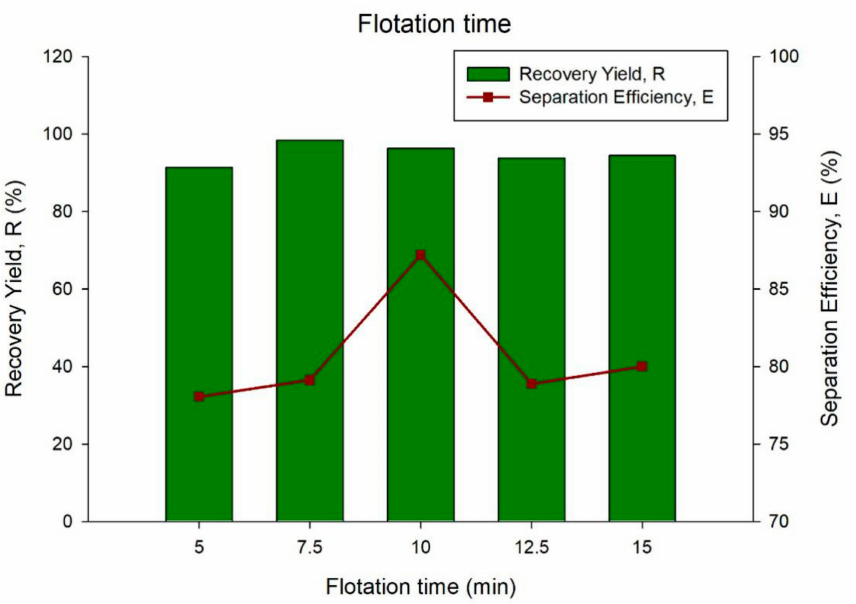
Figure 5. E ff ect of the the flotation time on the protein recovery yield and separation e ffi